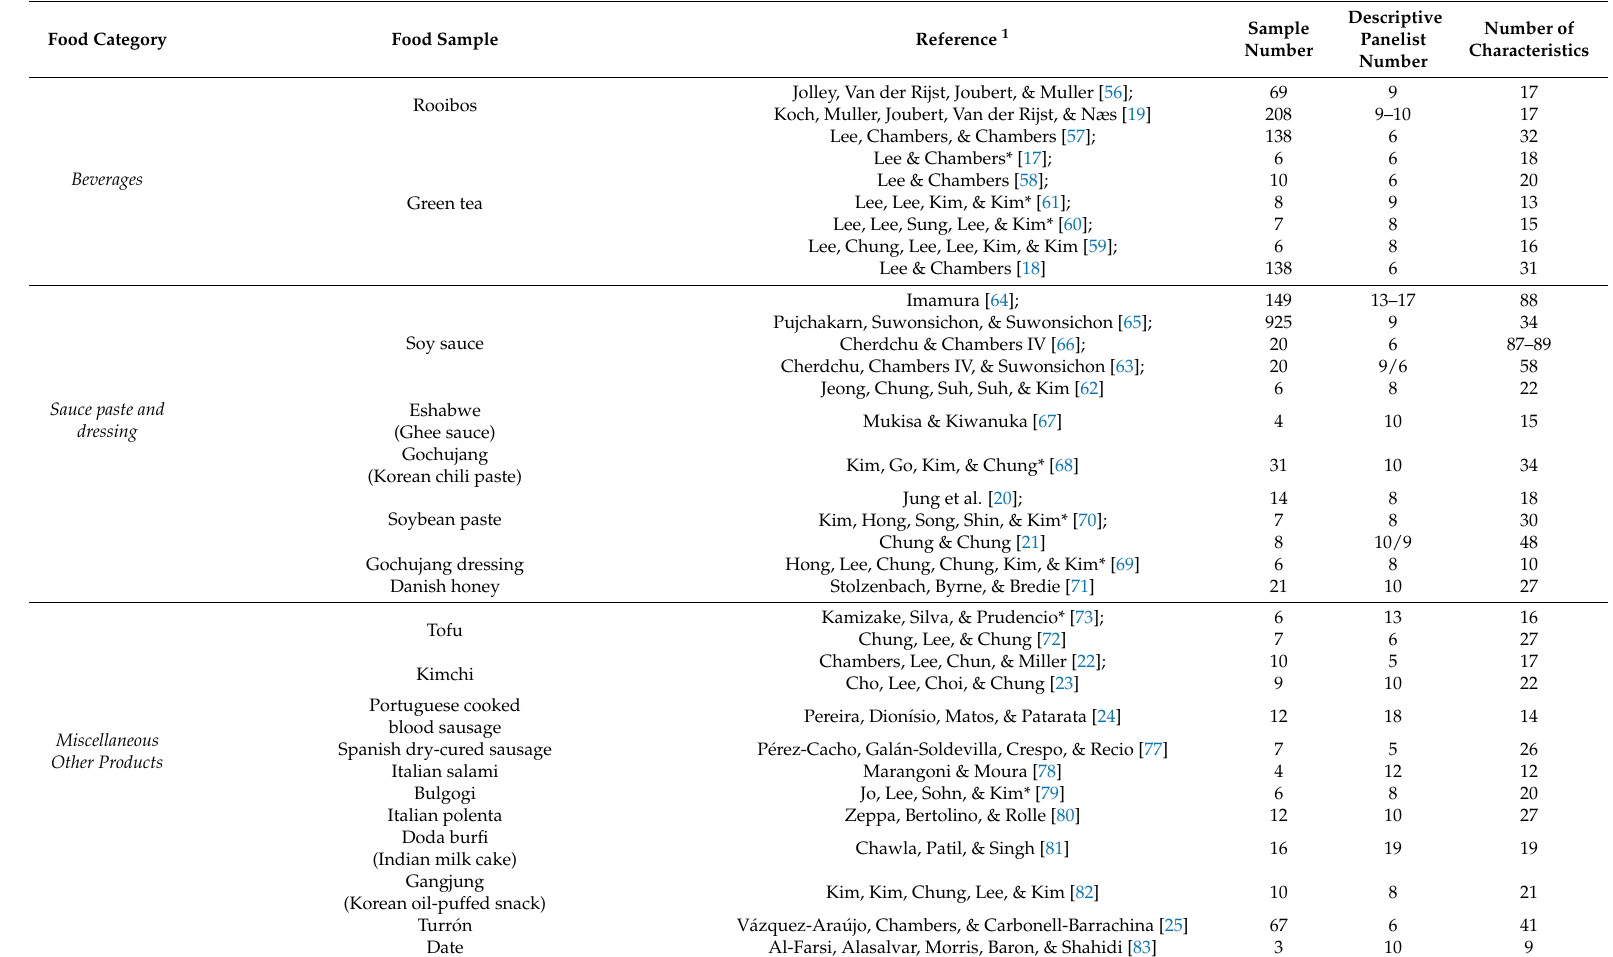
Table 1. Sensory descriptive analysis studies using traditional foods as